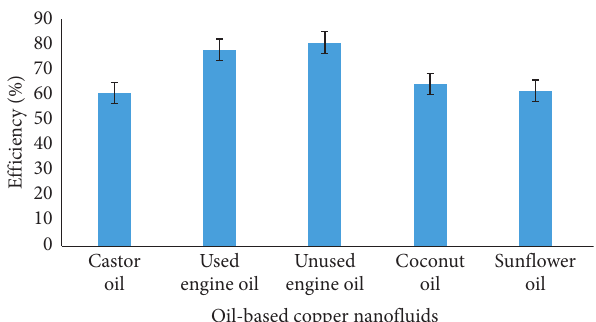
Figure 2: Efficiency of the oil-based copper nano-heat transfer fluids.